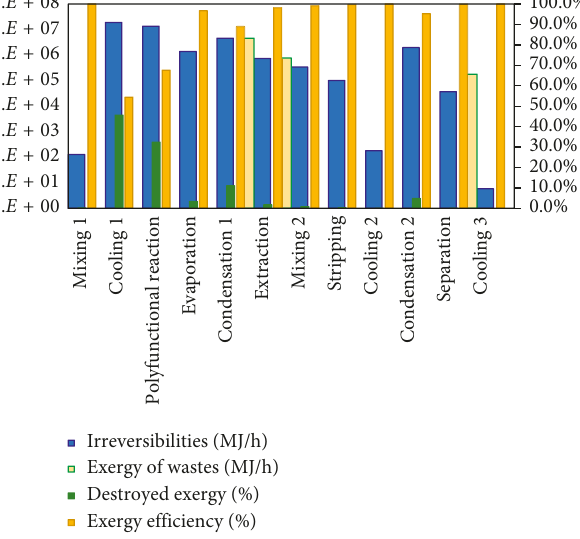
Figure 4: Exergy analysis results per process stage.